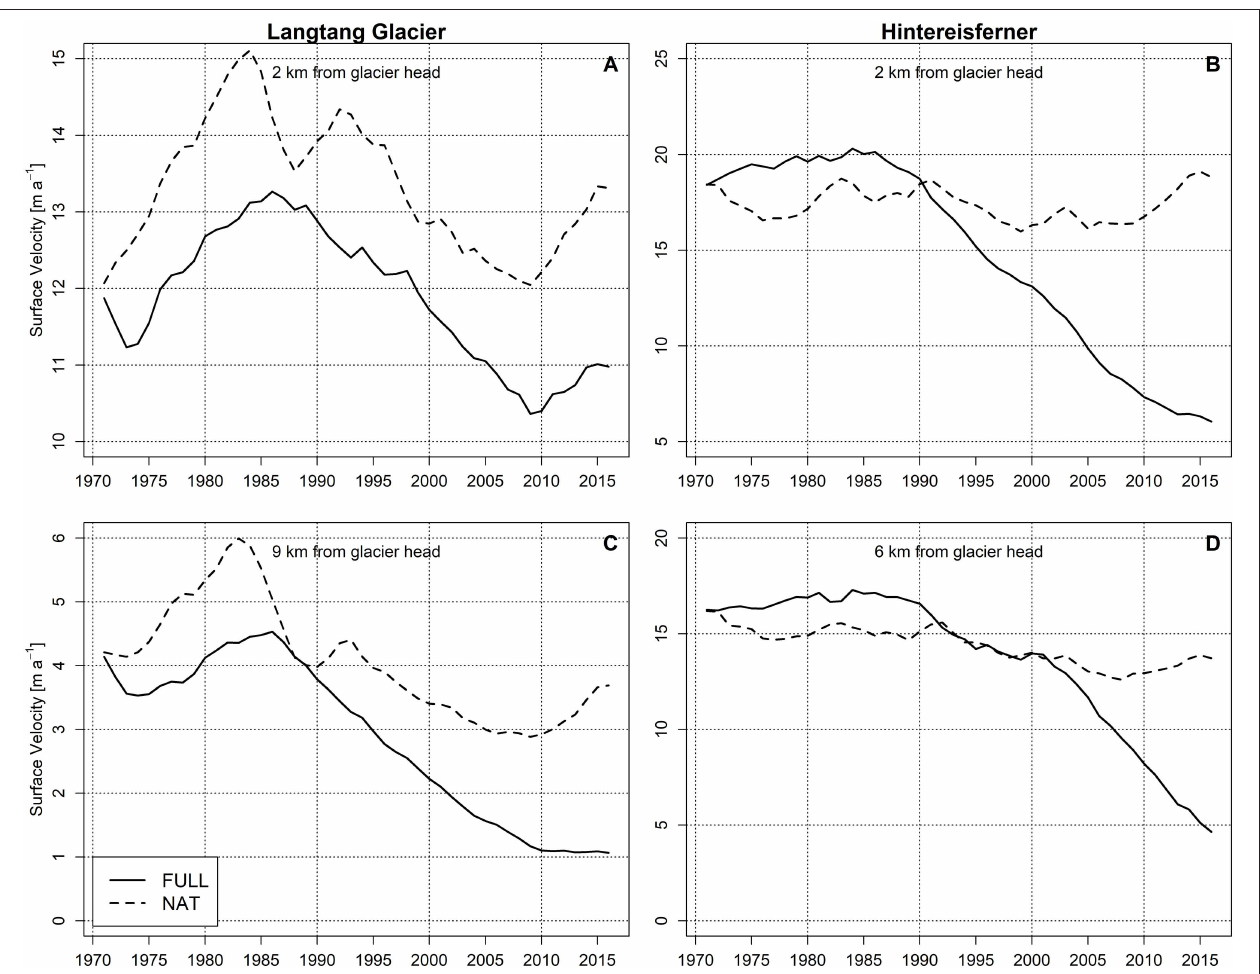
FIGURE 9 | Modeled changes in surface velocity at two different transects along Langtang Glacier (A,C) and Hintereisferner (B,D) for the cold/wet (Langtang Glacier) and cold/dry (Hintereisferner) FULL (solid) and NATURAL scenarios (dashed). The locations of the two transects are given in Figure 6 .